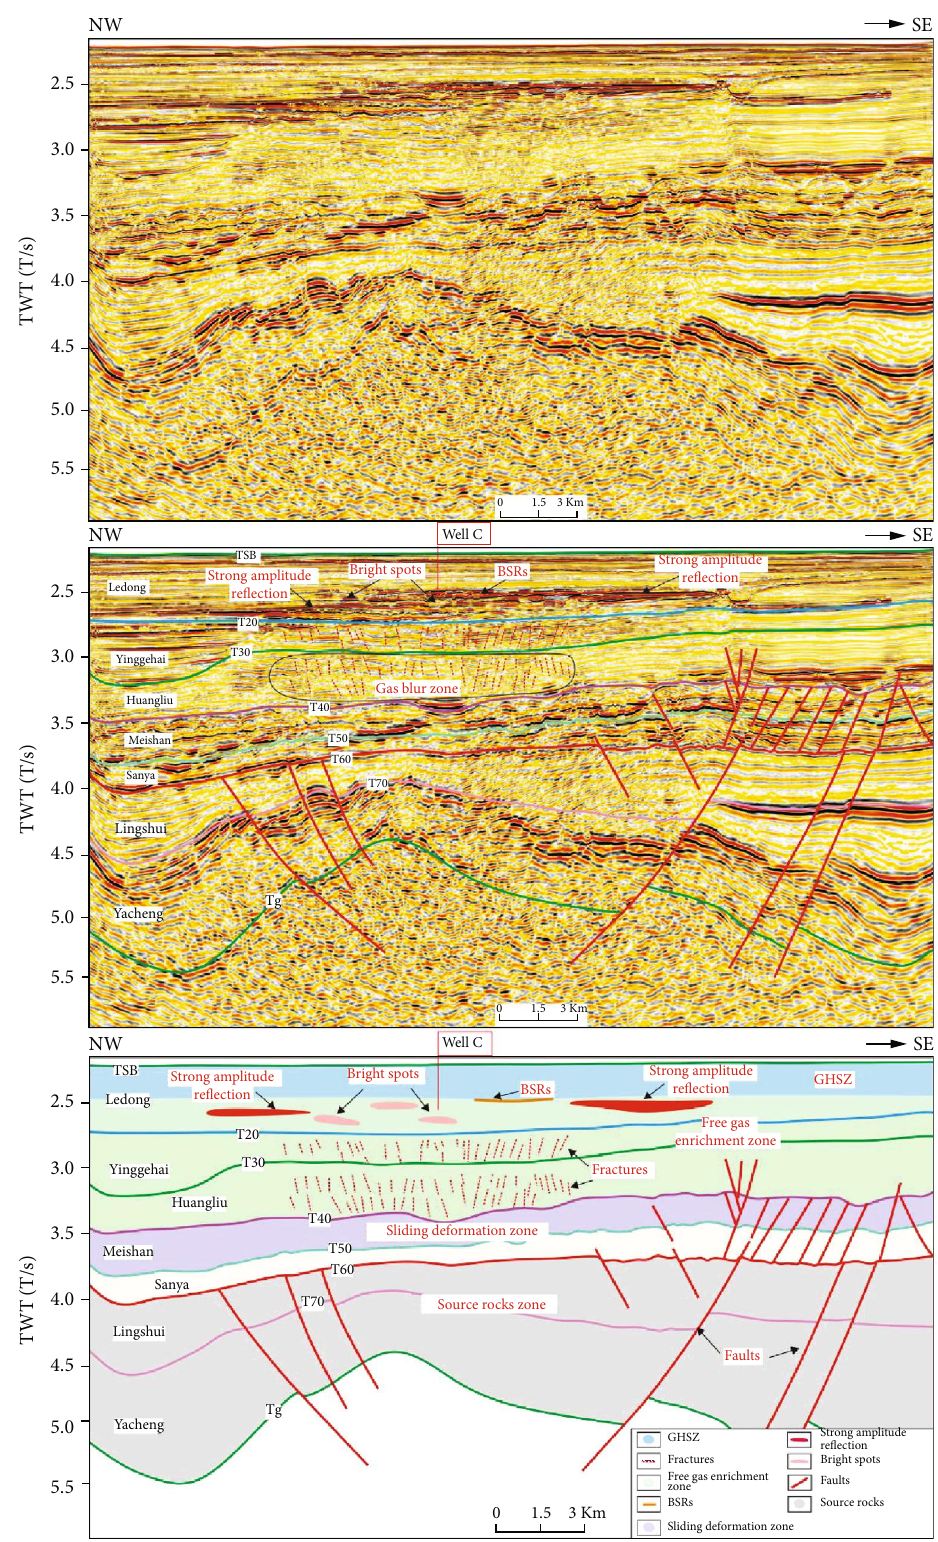
Figure 5: Faults and fracture system shown in the seismic pro fi le of line 3 in the QDNB (pro fi le location is shown in Figure